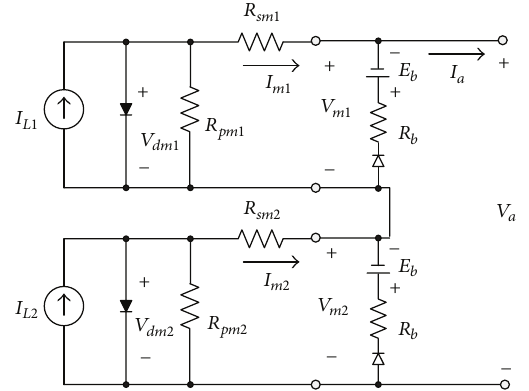
Figure 14: 𝑃 - 𝑉 curves of the array for 𝛼 = 0.8 kW/m 2 and different values of 𝛽 . The 𝑃 - 𝑉 curves have two peaks because of the effects of bypass